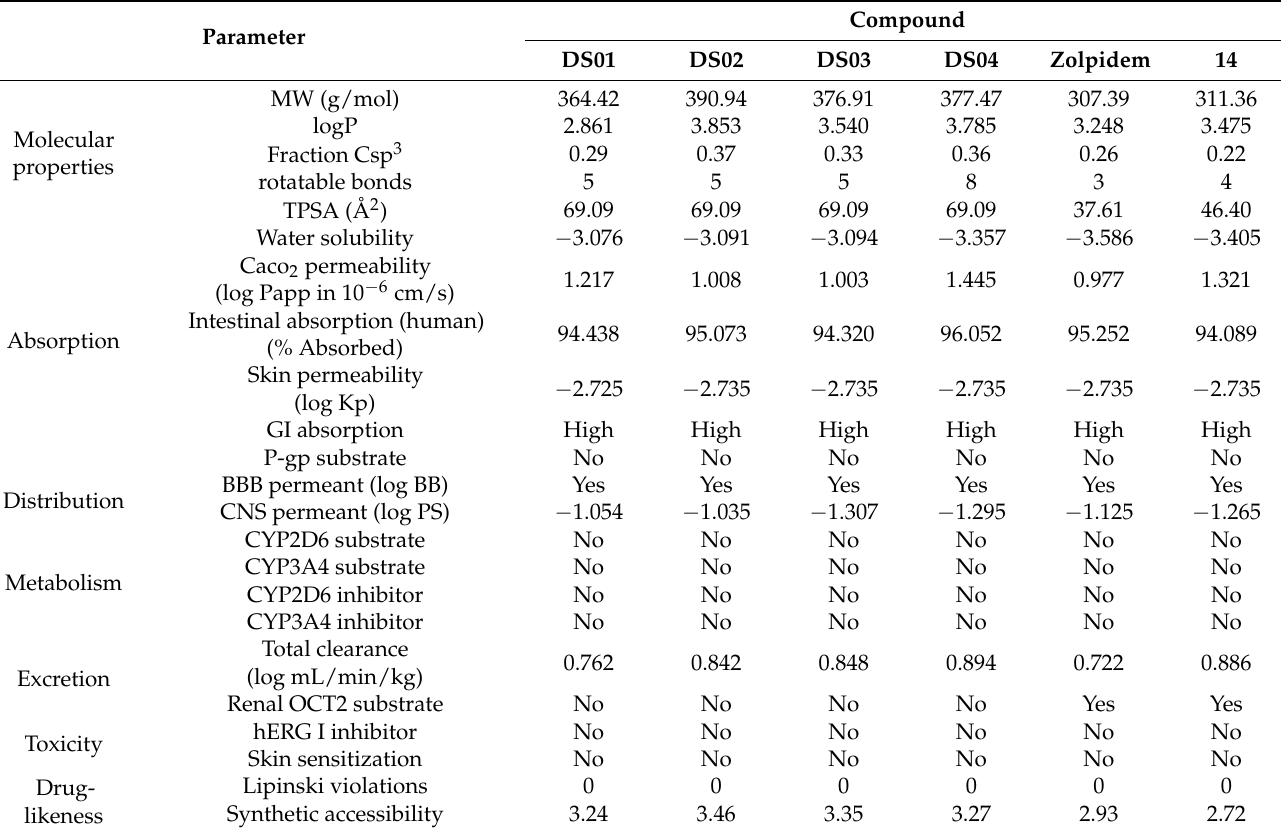
Figure 11. The virtual screening workflow for searching potential antipsychotic agents. Table 5. Predicted ADME/T properties of compounds DS01–04 , 14 , and